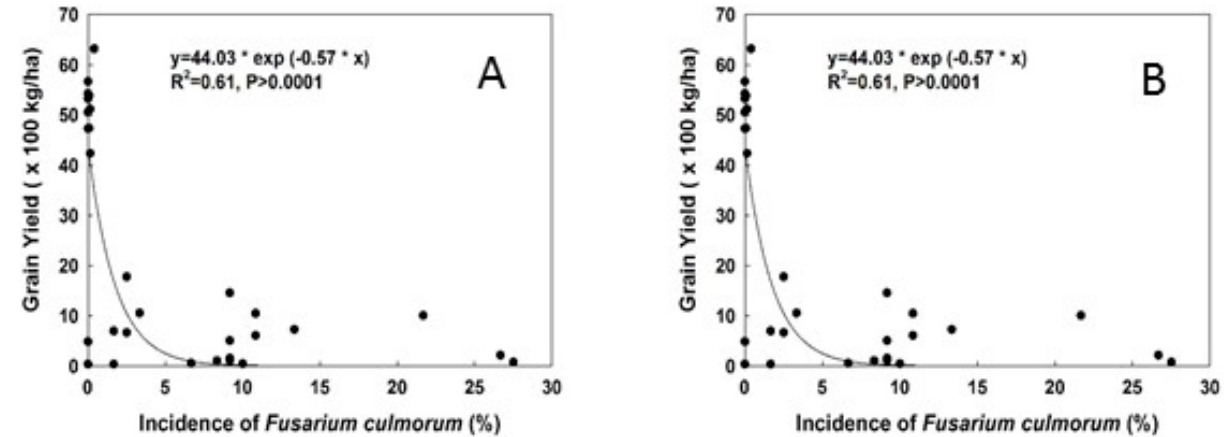
Figure 4. Mean of Fusarium culmorum ( Fc ) incidence of infection on roots (A) and stem bases (B) as a function of grain yield reduction for durum wheat cultivated in INRAT station at Kef over three experimental cropping seasons (2007–08, 2008–09 and 2009–10). Models were fitted with an exponential decay model with two parameters.